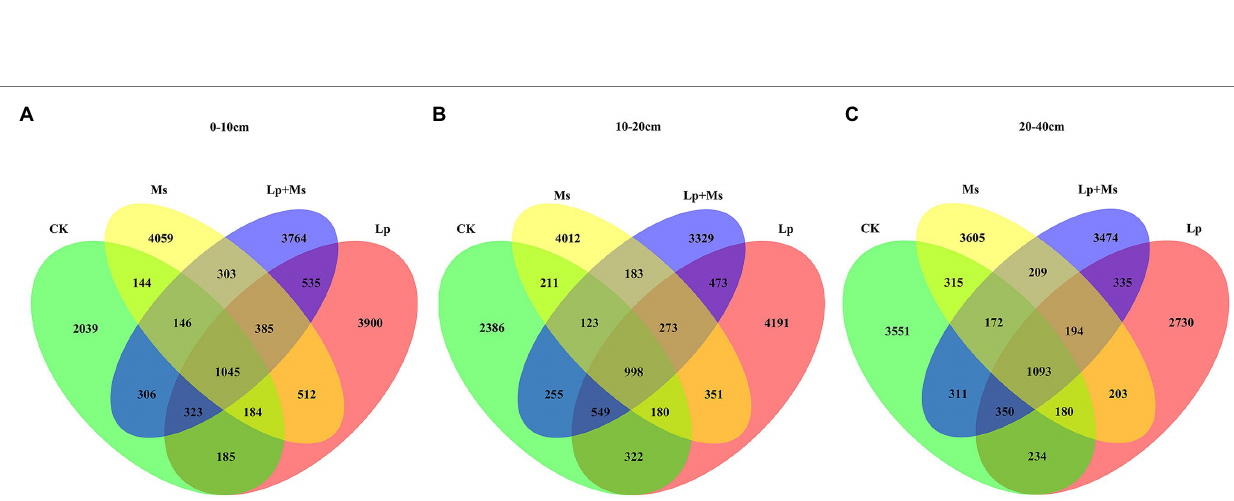
FIGURE 3 | Number of features in different intercropping grass modes: (A) 0–10 cm; (B) 10–20 cm; and (C) 20–40